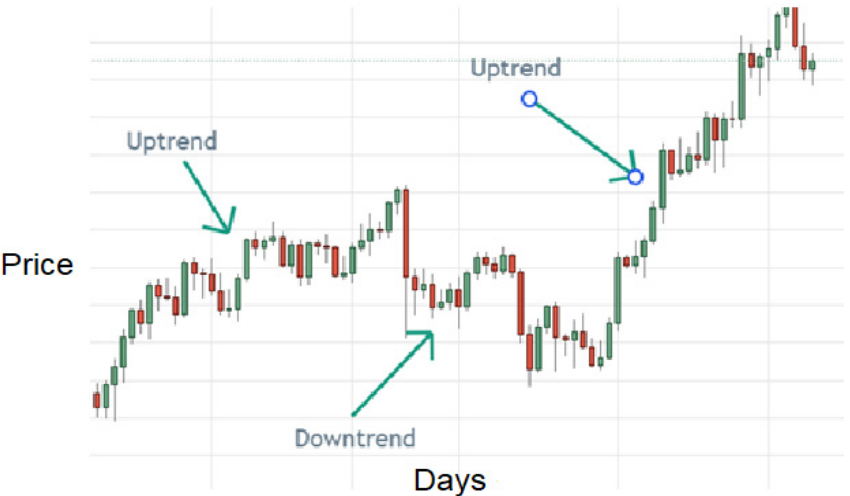
Figure 1. Uptrends and a downtrend of Bitcoin’s daily price. Each bar in Figure 1 contains information of the open, close, high, and low of the daily prices. A long red bar symbolizes a large daily price drop, and a long red bar sym- bolizes a major price rise. The system is designed to buy or sell one cryptocurrency at a time for easy comparison to the buy and hold (B&H) strategy. A specific number of days is entered into the system for it to calculate two consecutive EMAs and distributions and to establish whether the SSD condition of the current distribution over the latter exists. If such dominance is recognized, the system generates long or short trade. Once a position is realized, the system will stay in that position until an opposite dominance occurs. This trading system is highly sensitive to the range of days for which the SSD and EMAs are calculated. When it relies on a large number of days for those calculations, the number of executed trades drop dramatically, since it becomes difficult to recognize a continuous